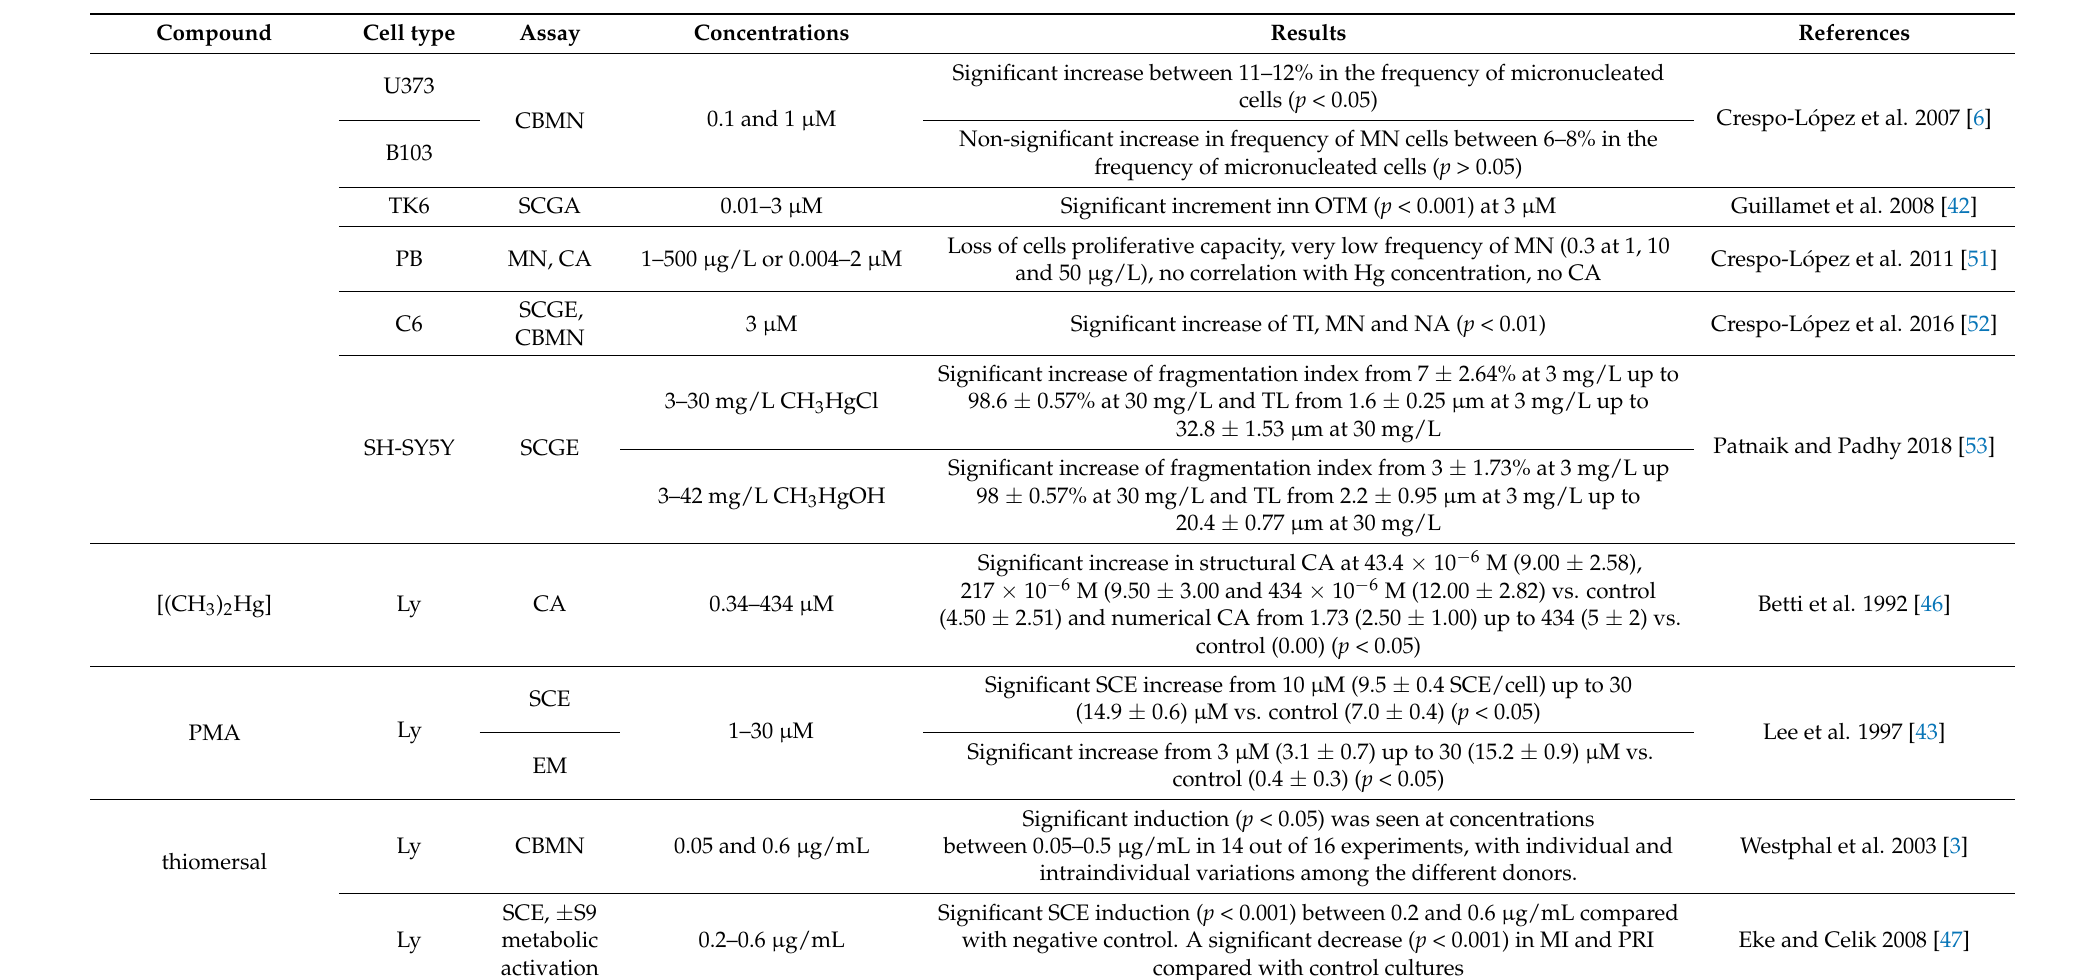
HeLa—human cervix epithelioid carcinoma cell line; MN- micronuclei; CBMN—cytokinesis blocked micronucleus assay; SH-SY5Y—human neuroblastoma cell line; C6—glioma cell line; U373—glioblastoma; B103—neuroblastoma; TK6—human lymphoblastoid cell line; PB—peripheral blood; Ly—human lymphocytes; CA—chromosomal aberrations; SCE—sister chromatid exchange; 8-OHdG—8-Hydroxy-2’- deoxyguanosine; EM- endoreduplicated mitosis; E—endoreduplication; SCGE—single cell gel electrophoresis or comet assay; PMA—phenylmercury acetate; C 2 H 5 HgCl—ethylmercury chloride; C 6 H 5 HgCl— Phenylmercury chloride or PMA; [(CH 3 ) 2 Hg]—Dimethylmercury; TL-tail length; TI-tail intensity; TM-tail moment; OTM—Olive Tail Moment; MI- mitotic index; PRI—proliferation